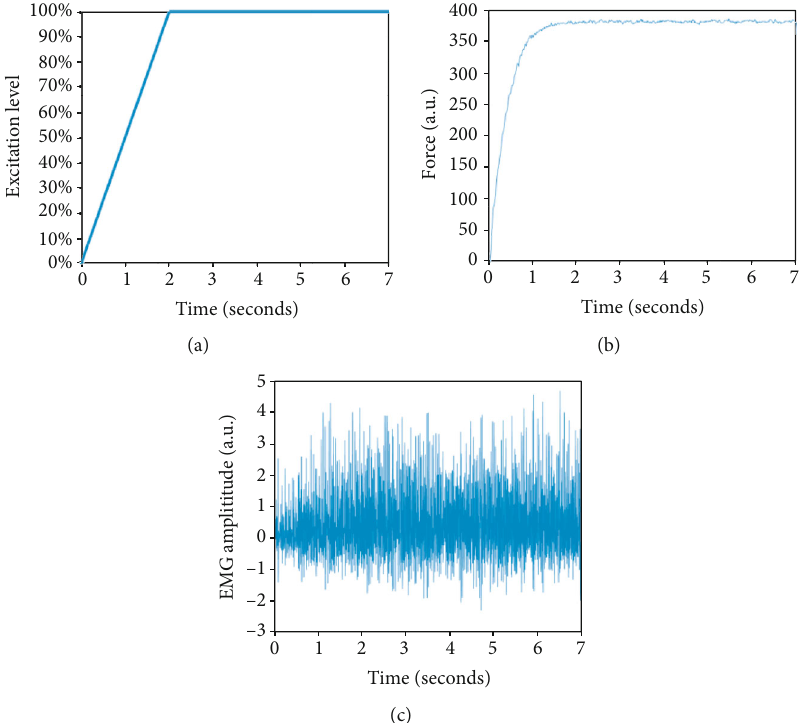
Figure 3: An example of (a) the excitation input simulation when the level was at 100% excitation and (b) the muscle force and (c) surface EMG outputs of the